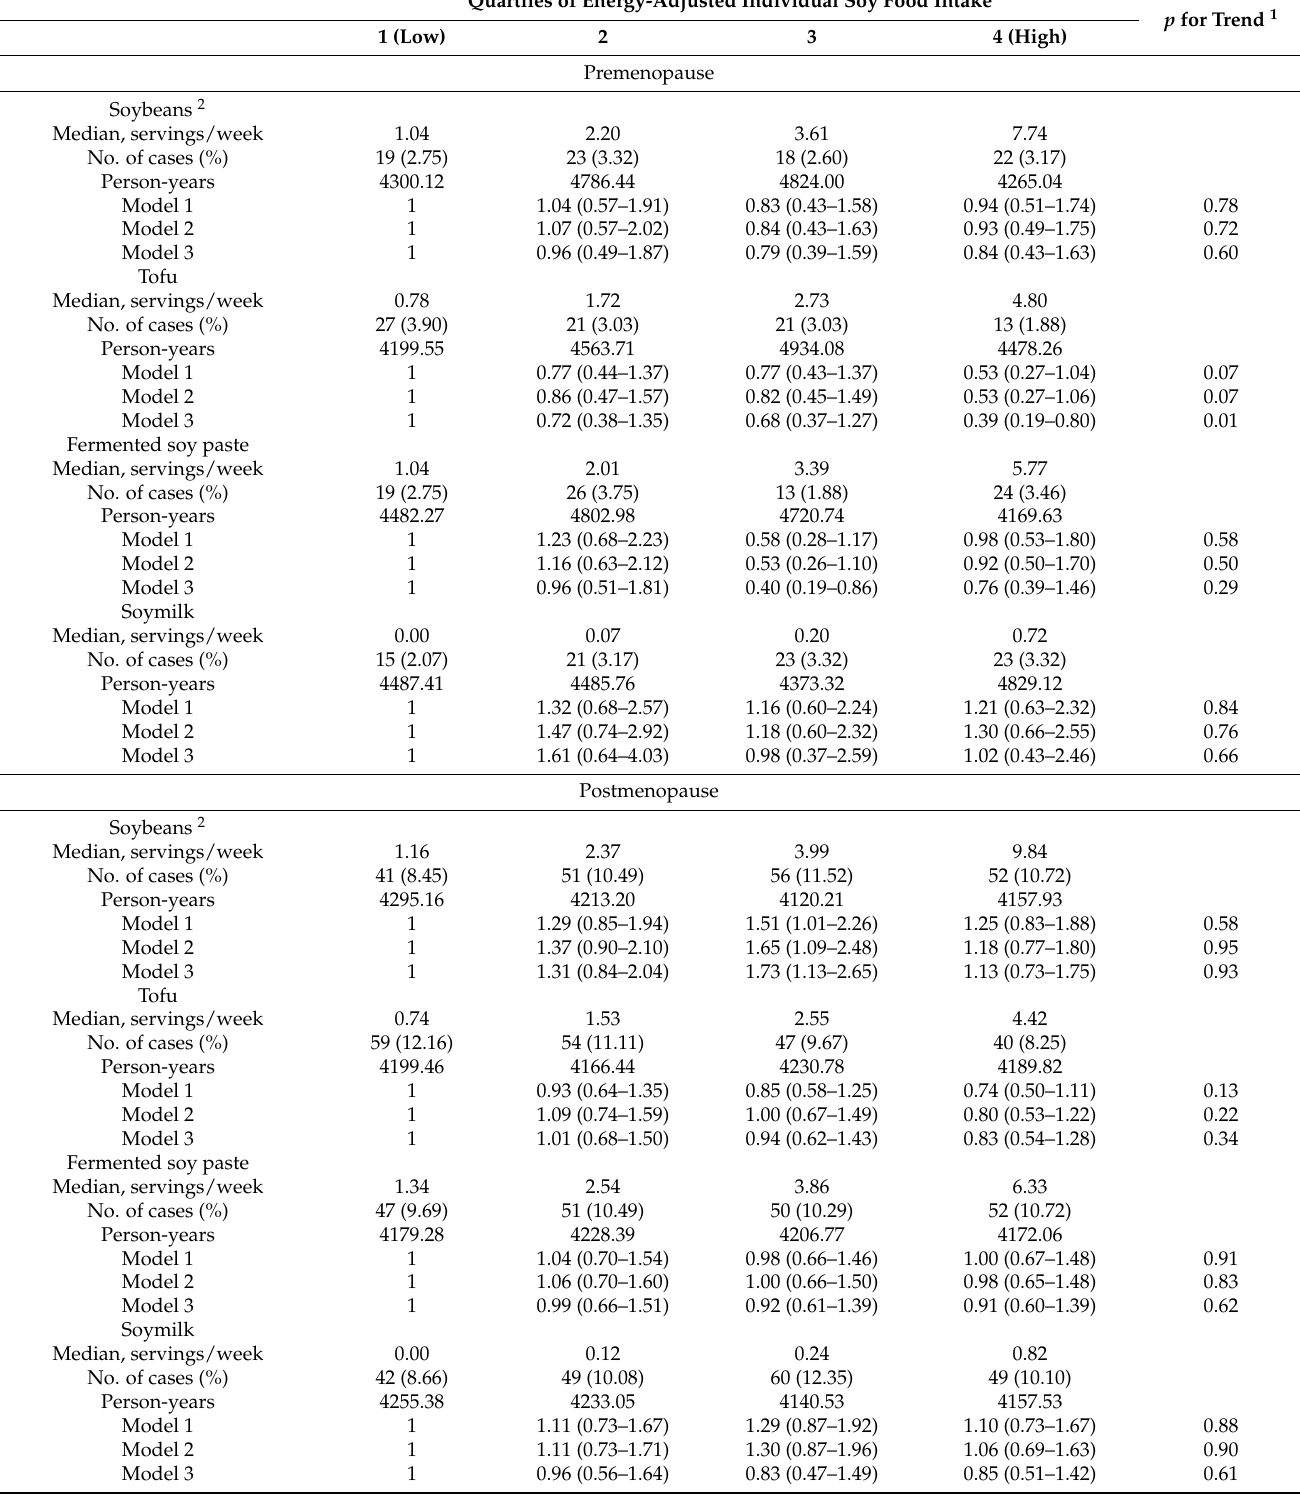
Table 4. Hazard ratios and 95% confidence intervals for cardiovascular disease by quartiles of energy-adjusted individual soy food